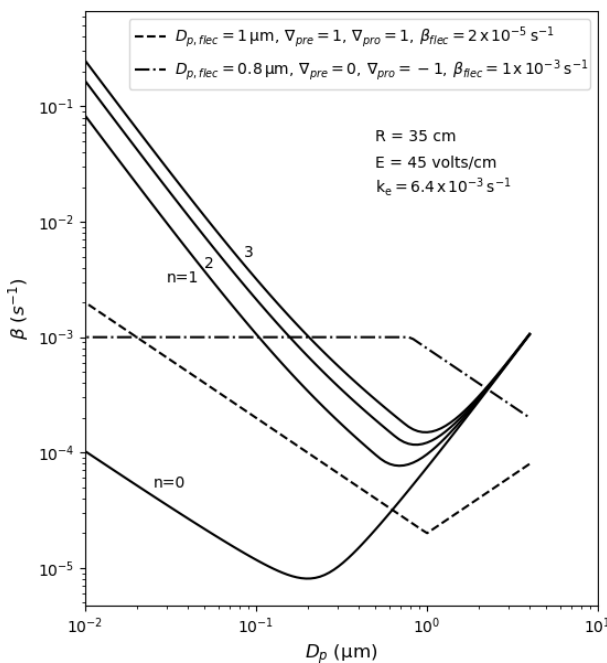
Figure 9. Example dependencies of the rate of particle deposition to walls using the model of McMurry and Rader (1985), shown by the solid lines; the charge per particle is given by n , and other inputs are given in the inset text ( R is spherical-equivalent chamber radius, E is the average electric field in the chamber and k e is the coefficient of eddy diffusion). The dashed lines demonstrate the observation- based deposition rate utility of PyCHAM given in Eq. (16), with inputs at the top of the plot.